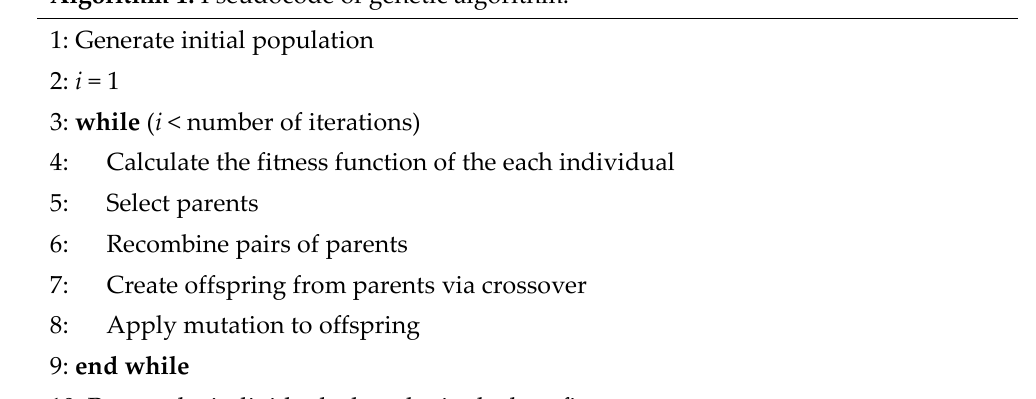
Algorithm 1. Pseudocode of genetic